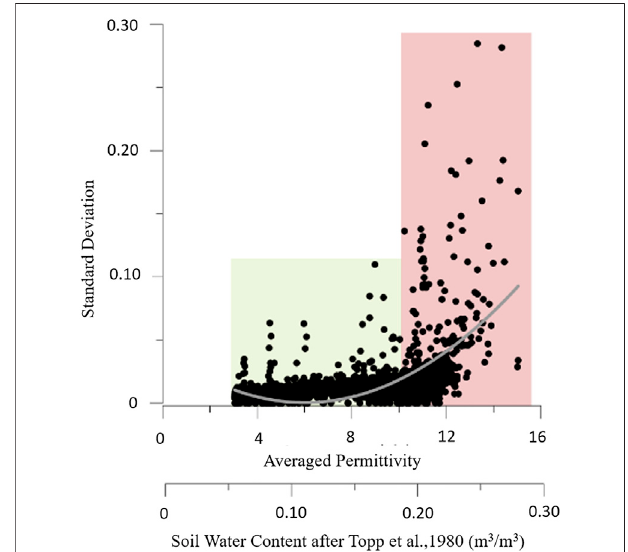
FIGURE 2 | Hourly averaged permittivity values of SMT100 probes and its standard deviation (STD, n (cid:1) 6) over a measuring period of 67 days. Classi fi cation according to scattering range possible (green): small STD range indicates nearly stable conditions and slightly changing conditions increase STD scatter range, (red): great STD range due to changing conditions; linear regression for both classi fi ed ranges and display of residual sum of squares and residual mean